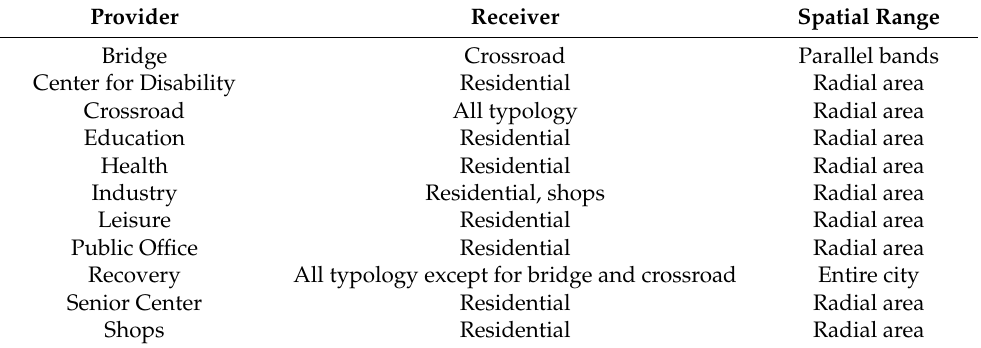
Table 3. Spatial ranges employed for establishing